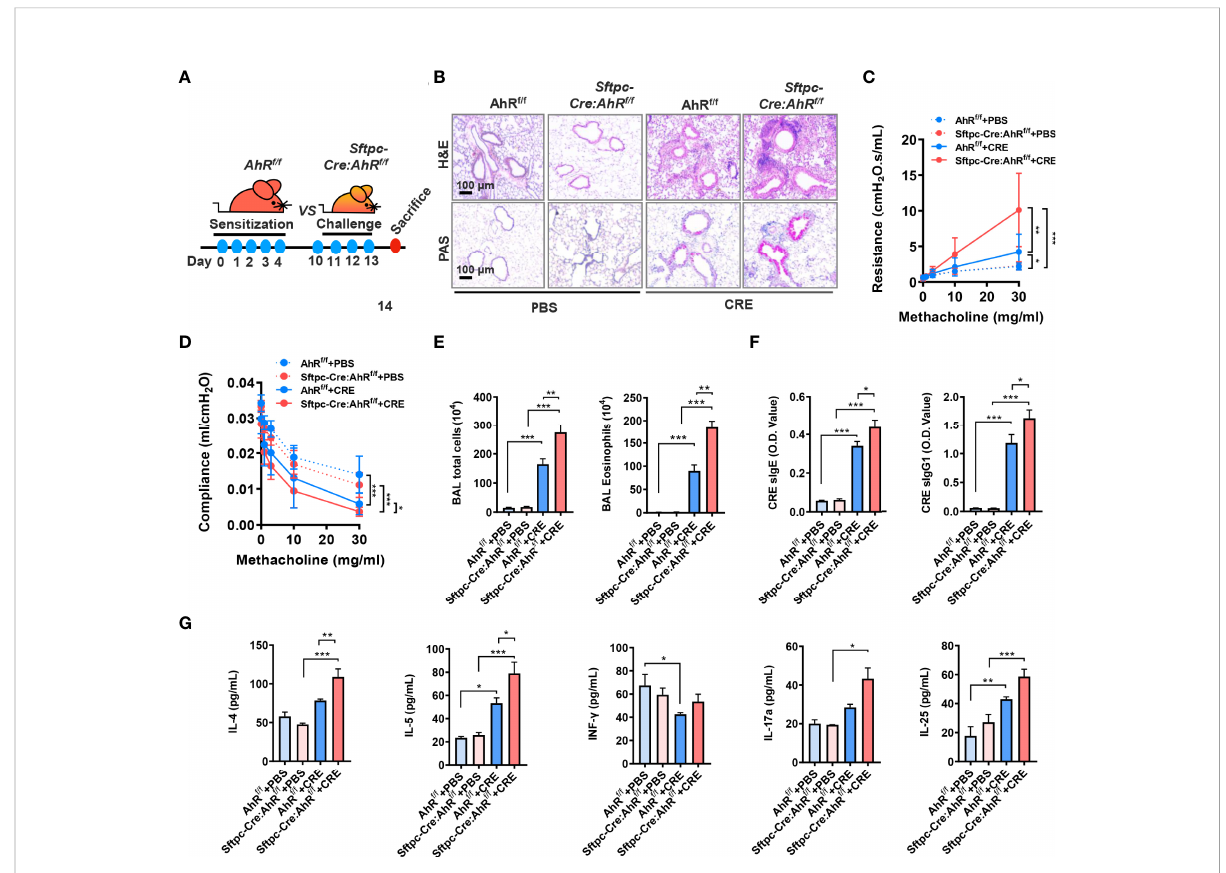
FIGURE 2 Type II alveolar epithelial cell AhR protects against airway hyperresponsiveness and allergic airway in fl ammation. (A) Experimental scheme for cockroach allergen – induced mouse model of asthma. (B) Histological examination of mouse paraf fi n lung sections stained with hematoxylin and eosin (H&E, upper panel) and Alcian Blue periodic acid – Schiff (AB-PAS, lower panel). (C, D) Lung resistance (C) and compliance (D) in response to increasing concentrations of methacholine using the forced oscillation technique (FlexiVent, SCIREQ). (E) Bronchoalveolar lavage (BAL) fl uid total and eosinophil cell counts as assessed by fl ow cytometry. (F) Serum levels of cockroach allergen – speci fi c IgE and IgG1. (G) Levels of cytokines in BALFs. n = 8 – 10. Data represent means ± SEM. * p < 0.05, ** p < 0.01, and *** p <